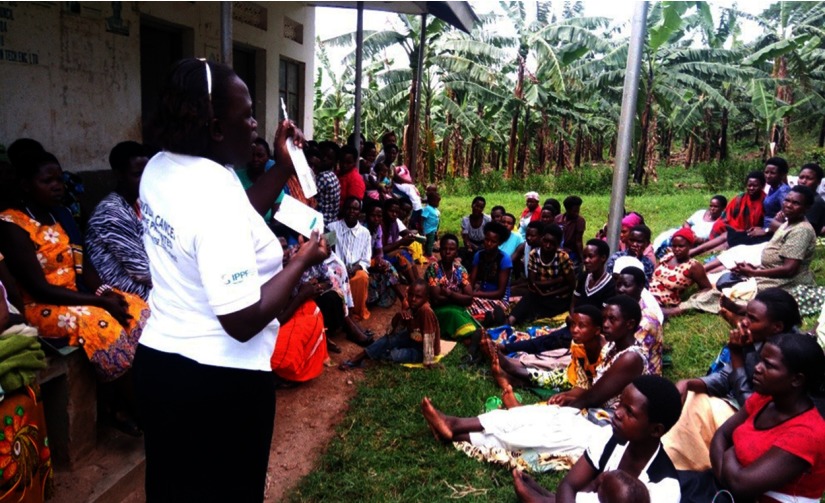
During an RHU outreach event in Kabarole district, Uganda, a provider shows women waiting for family planning services what Sayana Press looks like and provides information about the method. © 2016 Irene Kugonza/RHU.